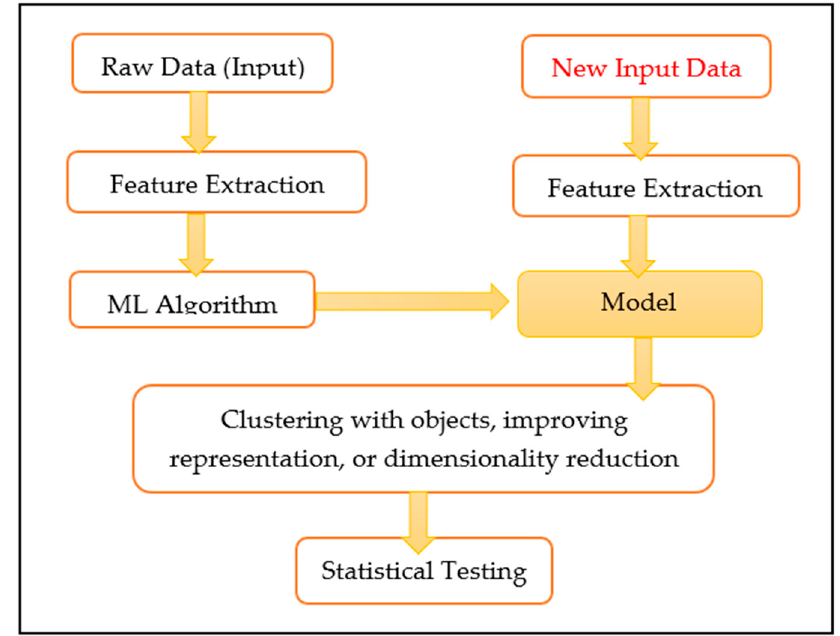
Figure 6. General unsupervised learning model.